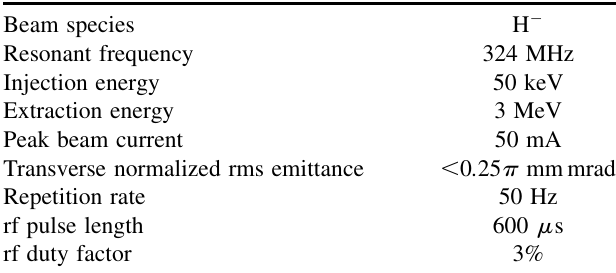
TABLE I. Requirements for J-PARC RFQ